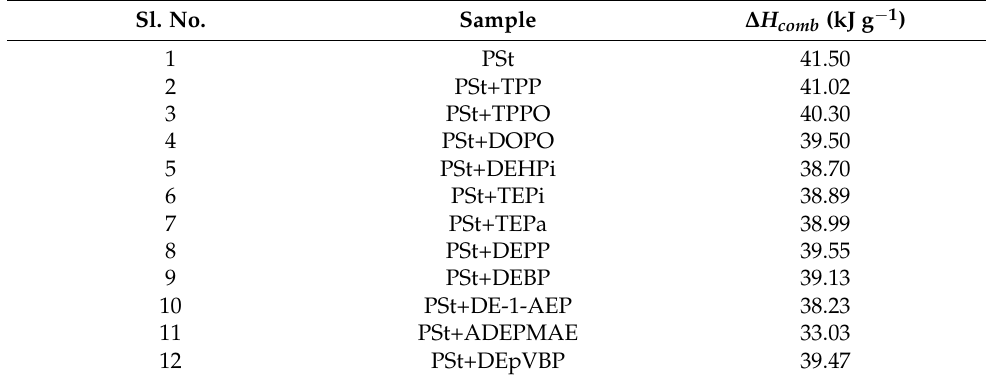
Table 6. Heats of combustion data for PSt-based samples from ‘bomb’ calorimetric measurements. Sl.